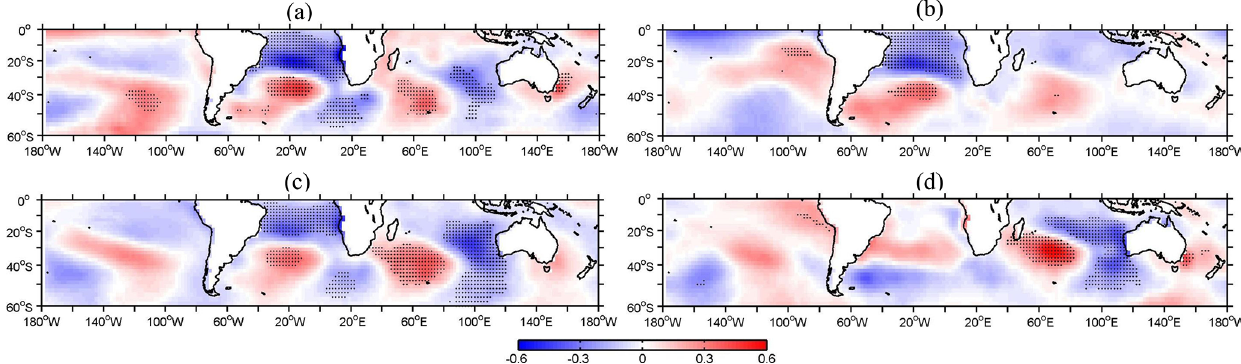
Figure 3. Regression maps of the SST anomalies ( ◦ C) on the summertime indices of (a, b) SAOD and (c, d) SIOD over the periods of (a, c) 1979–1999 and (b, d) 2000–2020. Dots denote the regions where the confidence level is above 95%.